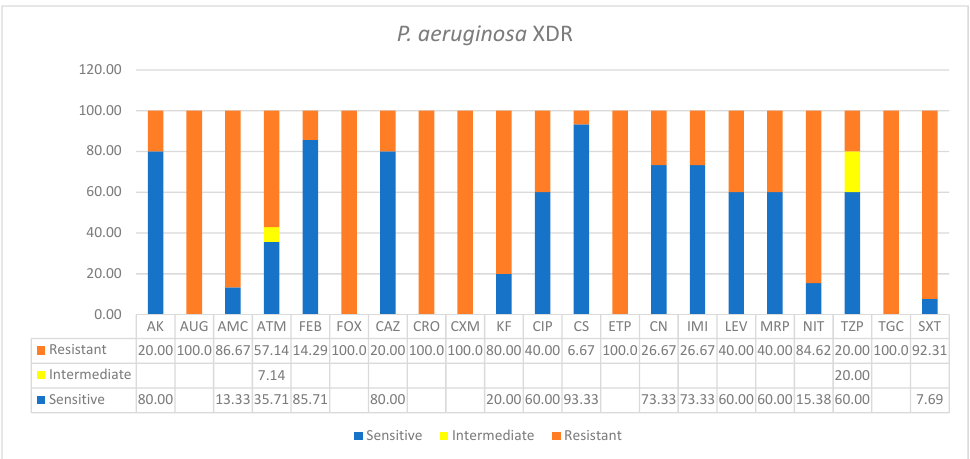
Figure 4. Antimicrobial sensitivity patterns of P. aeruginosa clinical isolates against 21 antibiotics. Abbreviations (in the order in which they appear in the figure): AK, amikacin; AUG, amoxicillin/clavulanic acid (2/1); AMC, ampicillin; ATM, aztreonam; FOX, cefoxitin; CAZ, ceftazidime; CRO, ceftriaxone; CXM, cefuroxime; KF, cephalothin; CIP, ciprofloxacin; CS, colistin; ETP, ertapenem; CN, gentamicin; IMI, imipenem; LEV, levofloxacin; MRP, meropenem; NIT, nitrofurantoin; TZP, tazobactam; TGC, tigecycline; SXT, trimethoprim/sulfamethoxazole. Isolates of “Other” bacterial species were from different types of specimens, such as urine, blood, sputum, wound, and pleural effusions, etc., and they were categorized under the name “Other species” (Table 1, Figure 5). These species were less in number and did not show a specific pattern of disease. In addition, except for a few, they were highly susceptible to a wide range of antimicrobials used. These drugs included AK, FEP, CAZ, ETP, CIP, LEV, MRP, CN, TZP, and SXT. However, “Other” organisms showed higher resistances, reaching 100% resistance in some cases (e.g., AUG, AMC, CXM, KF, CS, and NIT). In addition, higher ranges of intermediate resistances were observed by isolates of the species in this group over all other species reported.